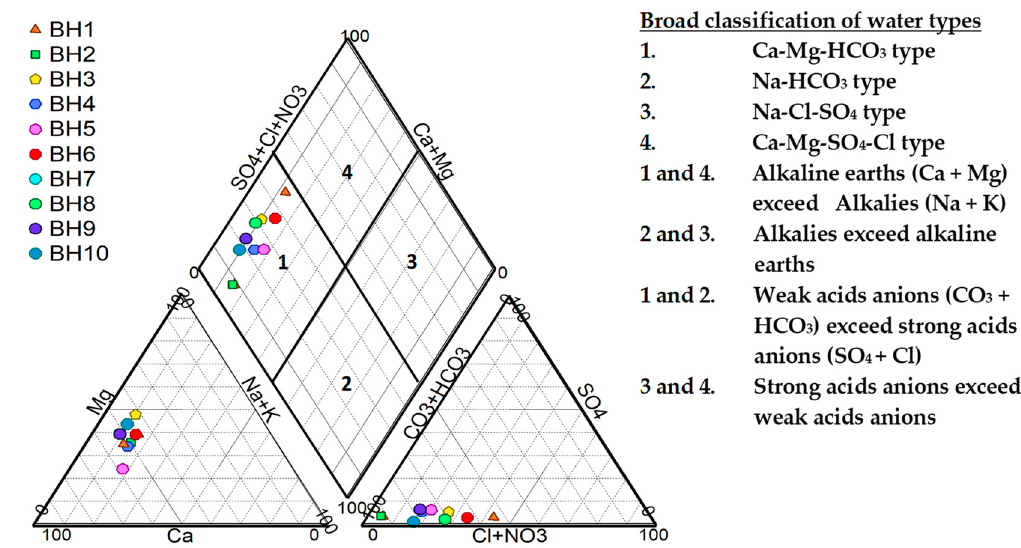
Figure 3. The Piper diagram showing the water types in the study area.